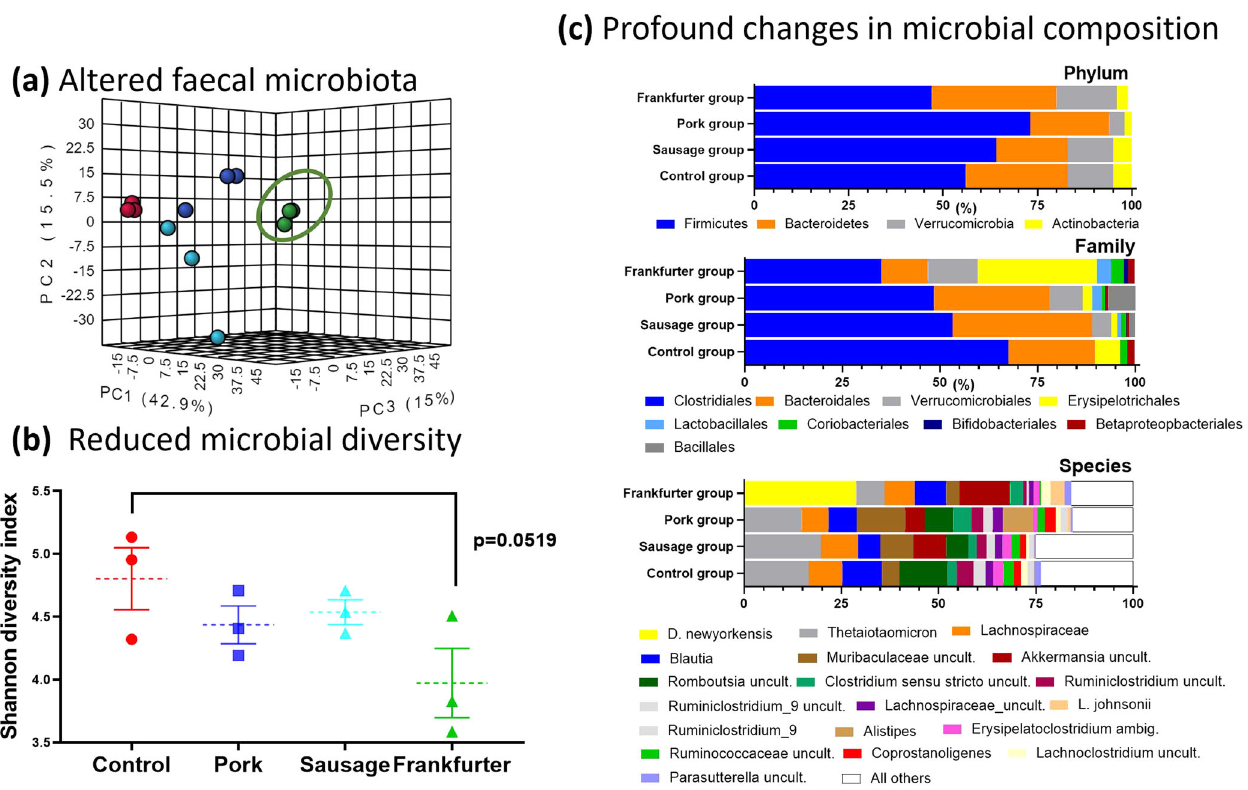
Fig. 4 Faecal microbiome pro fi les differ most in frankfurter-fed mice with reduced micribial diversity and a profound shift in abundance of taxa between feeding groups. Faecal samples were collected at 56 days from each mouse cage for metagenomic sequencing providing cage replicates ( n = 3) for each treatment. a shows scores plots of unsupervised PCA based on the fi rst three principle components (PCs). Species level microbiome data explained 73.4% of the total variation (42.9, 15.5, and 15.0% for PC1, PC2, and PC3, respectively). b the Shannon diversity index as calculated by Qiime 2 indicates a reduction in microbial diversity in the frankfurter-fed animals. Individual values are shown along with means (dotted lines), and the error bars shown represent s.e.m. c Relative abundance of microbial taxa is shown at the level of the phylum, the family, and the species. The taxa differed most profoundly in the frankfurter-fed animals. Bacterial species with an abundance of <1% were aggregated and referred to as ‘ All others ’ (white bars in fi gure). At the species level the dominance of Dubiosiella Newyorkenesis in the frankfurter group was a particularly striking observation. Control samples are shown in red, minced pork in dark blue, nitrite-free sausage in light blue, and frankfurter (nitrite-containing) in green. uncult. uncultured bacteria, ambig. ambiguous